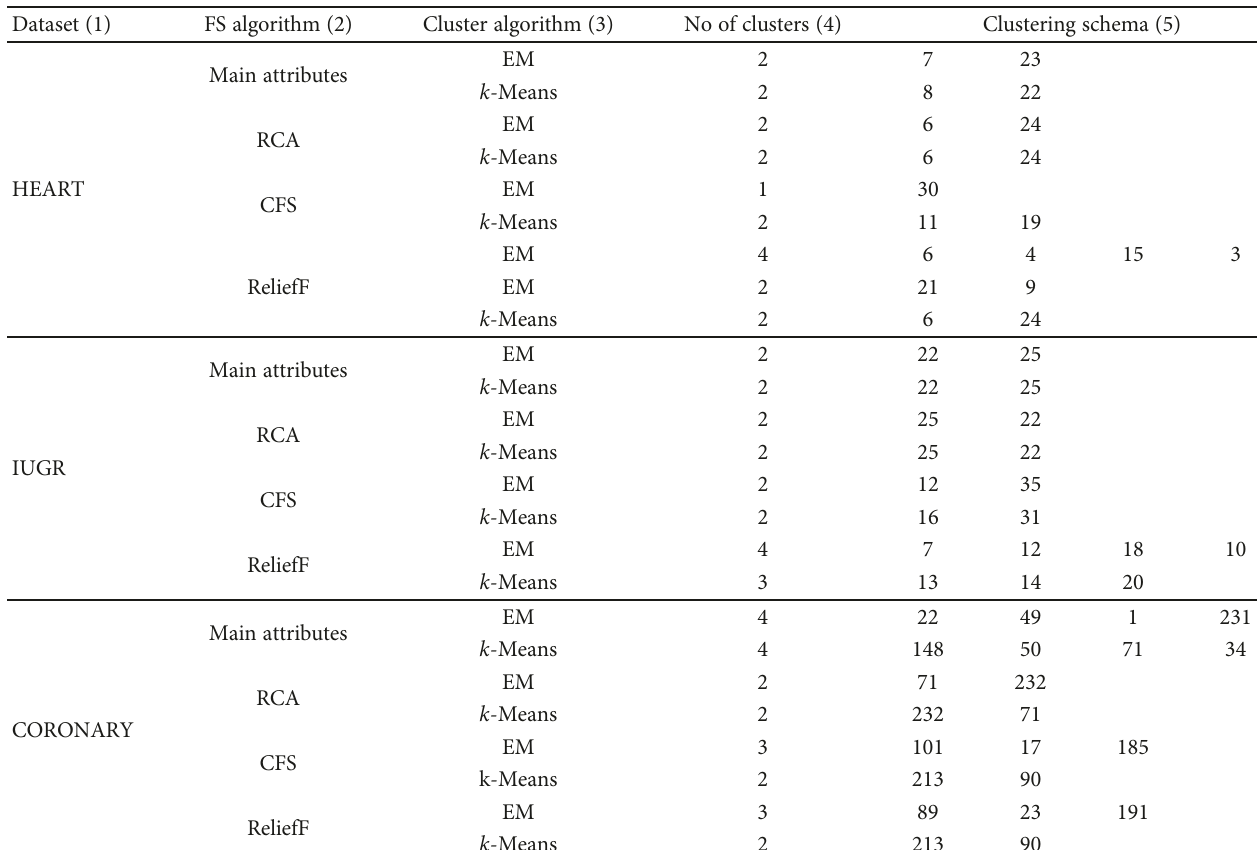
Table 6: Clustering results.